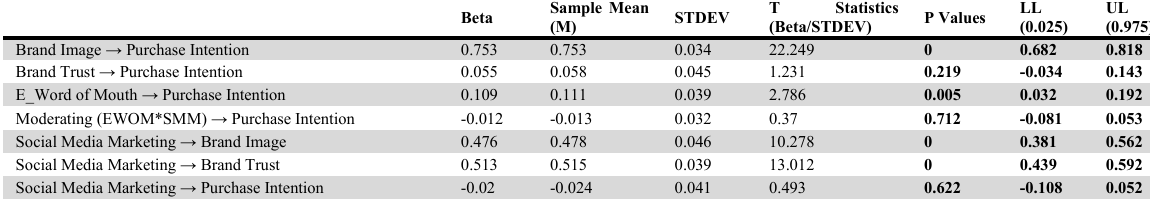
Direct path coefficient, mean, STDEV, t-values and p-values